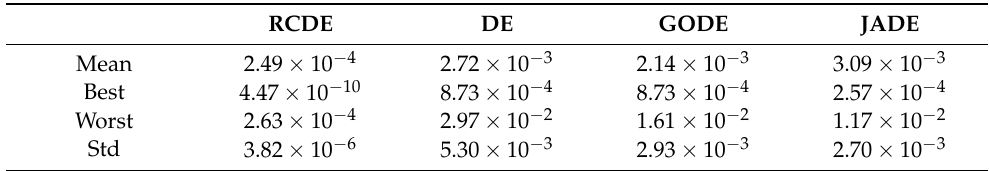
Table 6. Performance of four algorithms for solving Case 1.